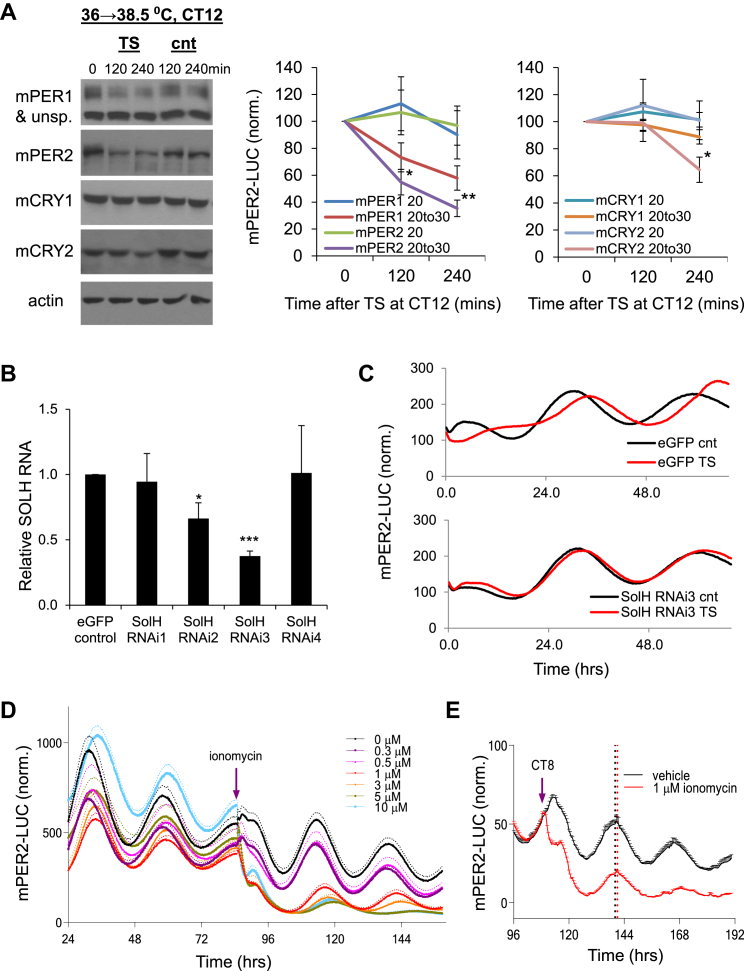
The Temperature Input Pathway Is Conserved in Mammals, Related to Figure 6(A) Western blots for thermal degradation of mammalian circadian proteins mPER1-2 (n = 9) and mCRY1-2 (n = 11) and their quantification.(B) RT-PCR results for downregulation of Solh in immortalized liver cells.(C) TP-induced phase delays in mPER2-LUC rhythms are reduced in Solh shRNA in liver cells.(D) Raw traces for ionomycin-induced dose-dependent degradation of mPER2 in lung fibroblasts.(E) Ionomycin application does not shift the mammalian clock at CT8. Error bars: SEM for (A and B). p < 0.05 or p < 0.001 from at least four independent experiments (n ≥ 3 each) is indicated with “∗” or “∗∗∗.”